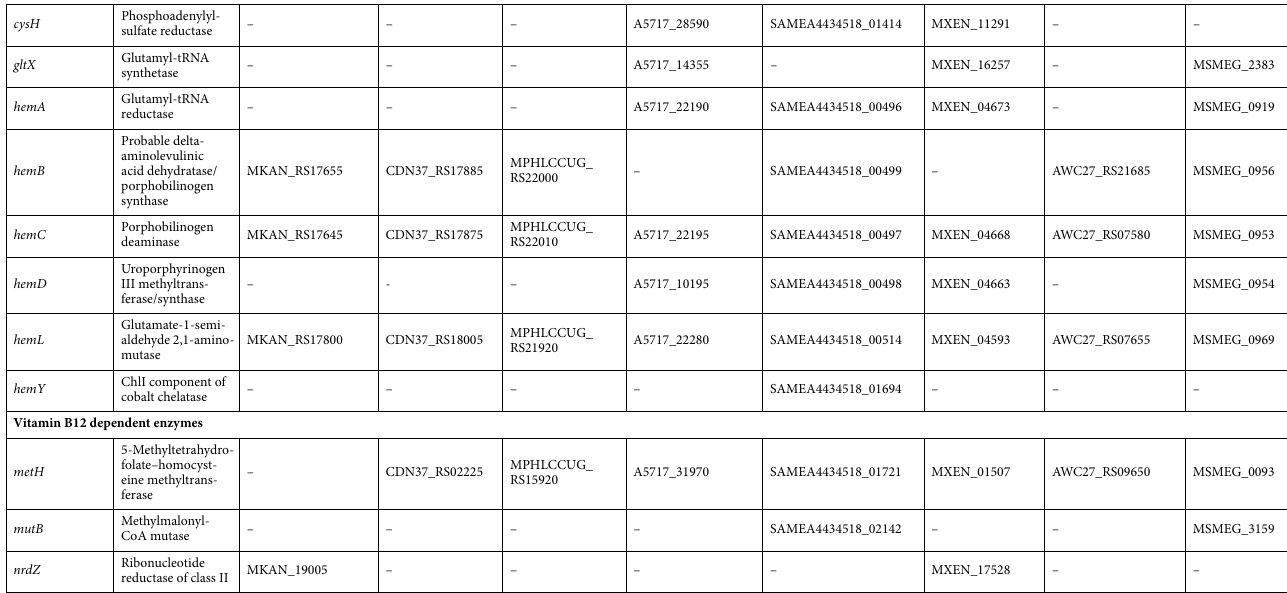
Table 1. Identification of genes involved in vitamin B12 metabolism in various mycobacteria species based on publicly available annotations in major